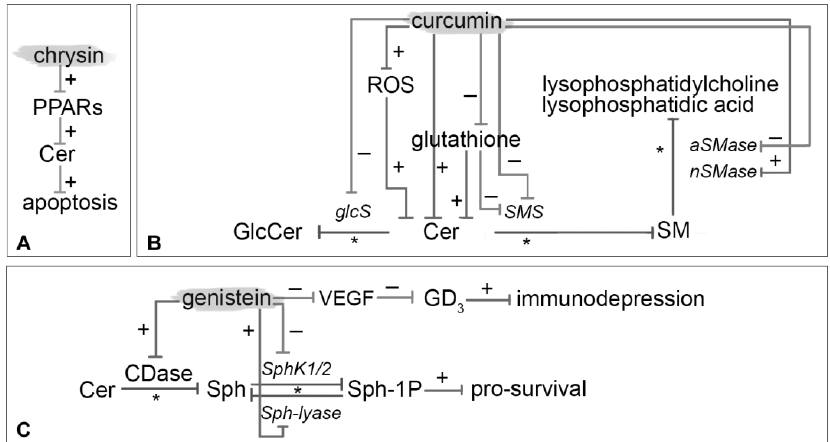
Figure 4. Mechanism of modulation on sphingolipids by chrysin ( A ), curcumin ( B ) and genistein ( C ). It is depicted with an asterisk (*) enzymatic pathway, with plus (+) red-regulated pathway and with minus (−) down-regulation ones.